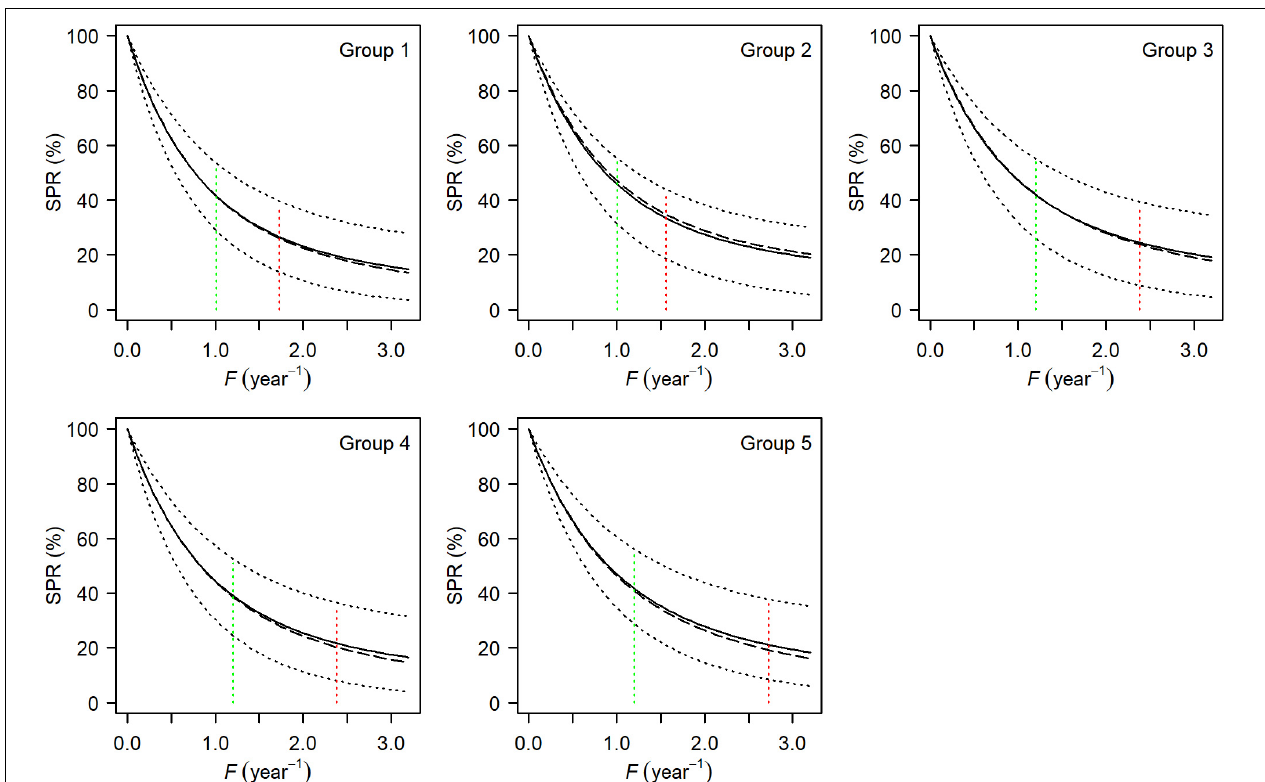
FIGURE 6 | Mean (solid line), median (long-dashed line), and the 95% HDI (dotted line) of spawning potential ratio curves for each group of small yellow croakers when t max = 3 years. Green and red dotted lines show the position of F MSY and F cur ,